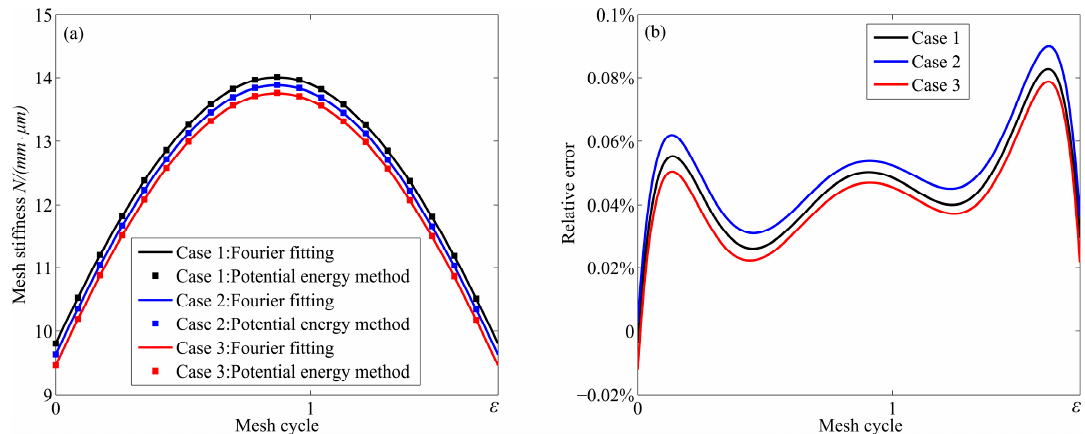
Figure 6. The single-tooth-pair mesh stiffness: ( a ) Comparison of calculated stiffness and fitted stiffness. ( b ) Relative error curve.